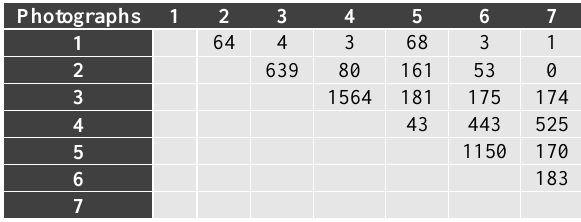
Table 6. Example of matching record matrix.